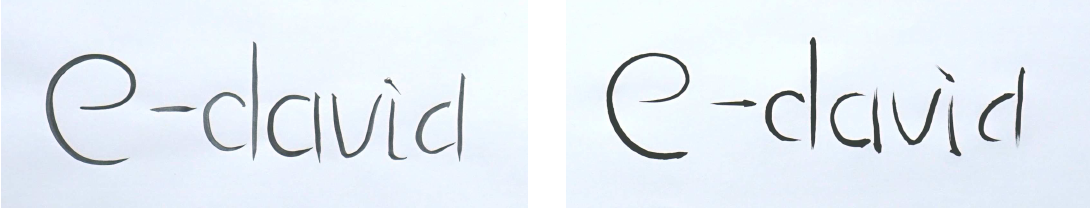
Figure 9. A reproduction of writing presented to the robot on the canvas without additional input. Human writing is shown on the left and the corresponding robotic reproduction on the right.